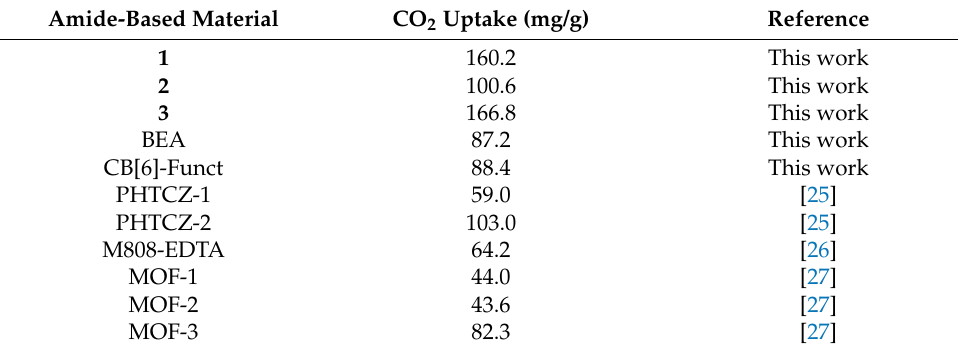
Table 1. Comparison of CO 2 uptake abilities of amide-based materials.